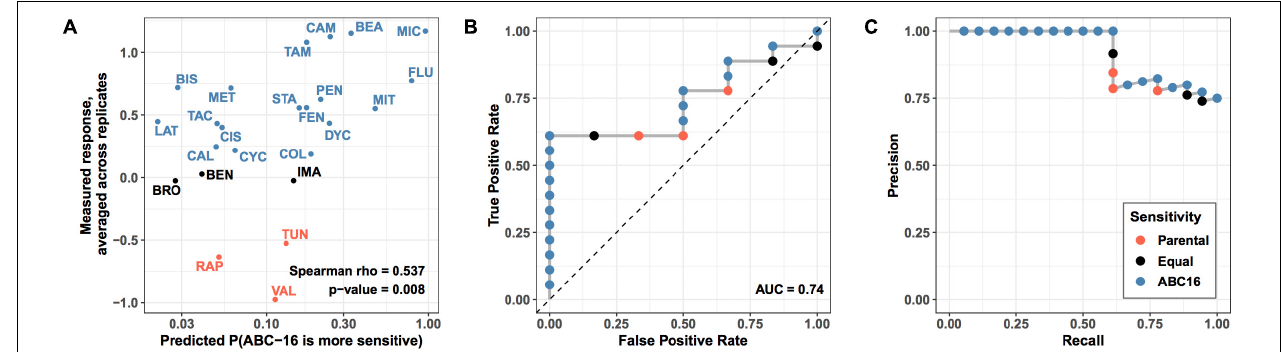
FIGURE 5 | Performance of prospective validation of substructure-based prediction of relative efficacy against ABC-16 yeast. (A) For each drug in test set, the X axis shows the predicted probability of ABC-16 sensitivity, and the Y axis shows the relative efficacy scores –log2(ABC-16 growth/parental strain growth). These scores are higher for compounds to which ABC-16 is sensitive. Substructure-based relative efficacy predictions significantly correlated with the mean relative efficacy scores from two replicates (Spearman rho = 0.54, permutation test p -value = 0.007), accurately capturing ABC-16 yeast’s sensitivity to fluconazole and miconazole, and ABC-16 yeast’s resistance to tunicamycin, rapamycin and valinomycin. (B) ROC curve showing predictor performance on the validation data, where drugs with higher efficacy against ABC-16 yeast are treated as “positive” examples, while drugs with lower or equal efficacy are treated as “negative” examples. (C) The matching precision-recall curve. All points across all panels are colored consistently with Figure 4 , with drugs that have less, equal or more efficacy to ABC-16 compared to wild type yeast being shown in orange, black and blue,